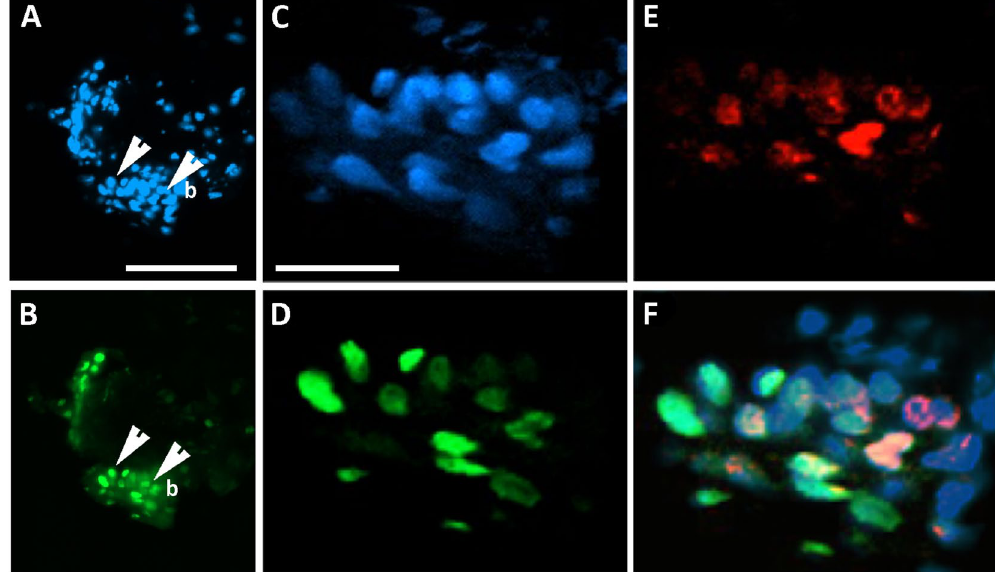
Figure 5. Pulse-chase co-labeling of H2B-GFP and BrdU at the limbus identify slow cycling and mitotically dividing cells. K5Tta × TRE-H2BGFP + mice at 21d old were injected with BrdU and fed with dox for 19 d as described in the Methods. ( A ) DAPI nuclear staining of the corneal limbal region co-localizes with ( B ) H2B-GFP + expressing cells. Higher magnification of the limbus shows detailed ( C ) DAPI nuclear staining that co-localize with ( D ) H2B-GFP and ( E ) BrdU. ( F ) The merged image shows co-localization of a group of H2B-GFP + cells with BrdU at the limbus indicating that some cells are still dividing after the chase period. b, basal layer; white arrows in A&B point to the basal cells of the cornea, enlarged in C − F respectively. Scale bar A − B = 100 μ m, C − F = 25 μ